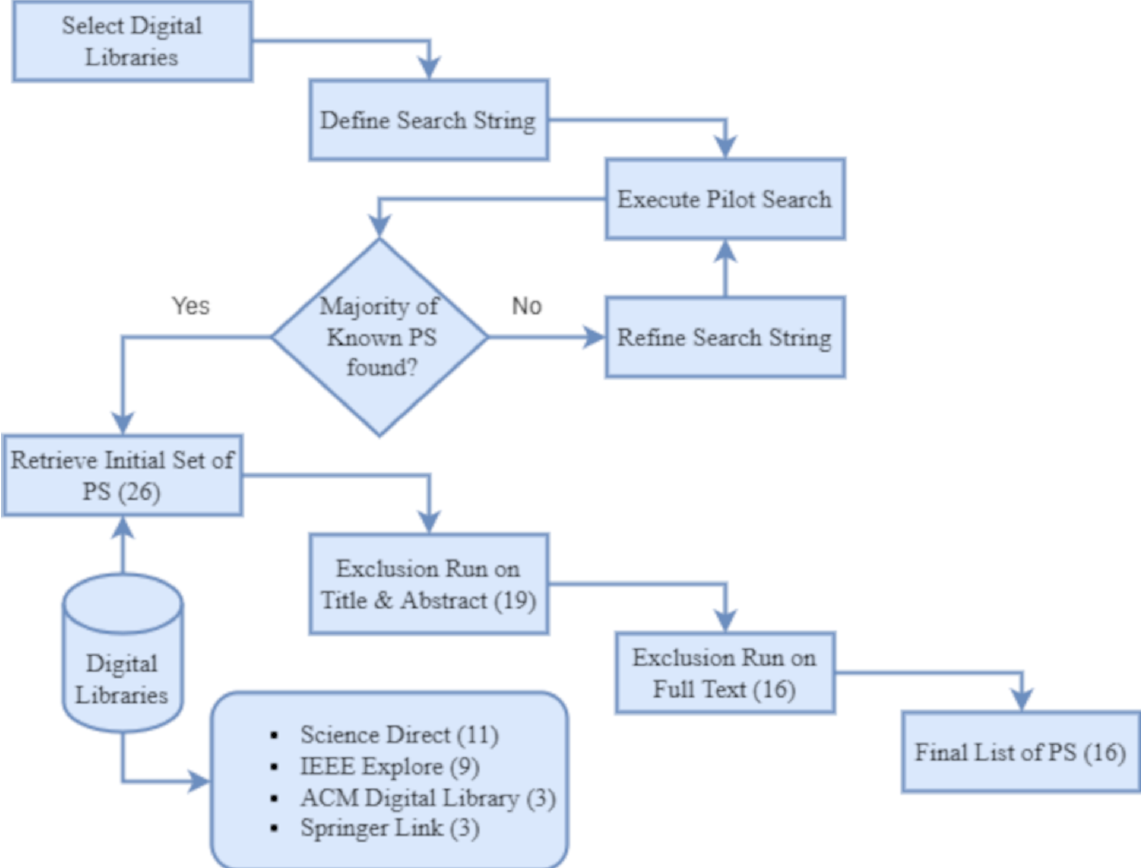
Figure 2. Process for searching and selecting